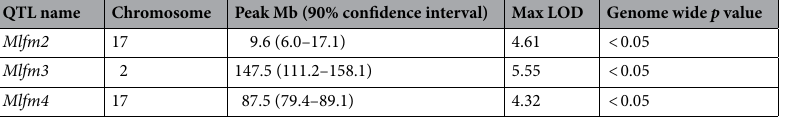
Table 2. Macrophage lysosome function modifier QTLs after adjusting for Mlfm1 .